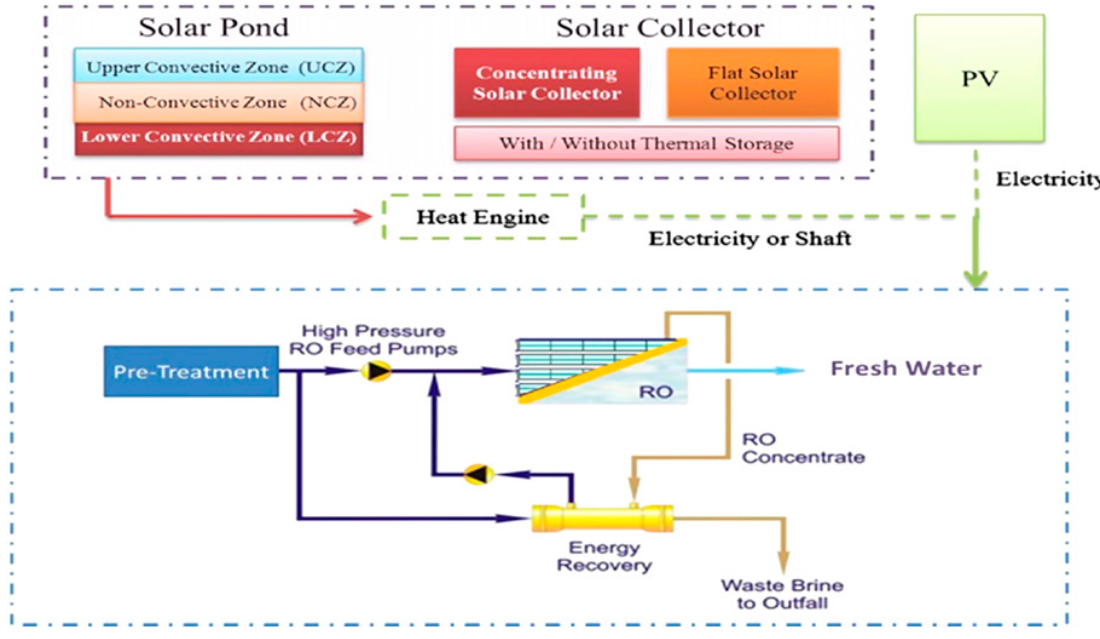
Figure 11. Solar powered RO system [92].